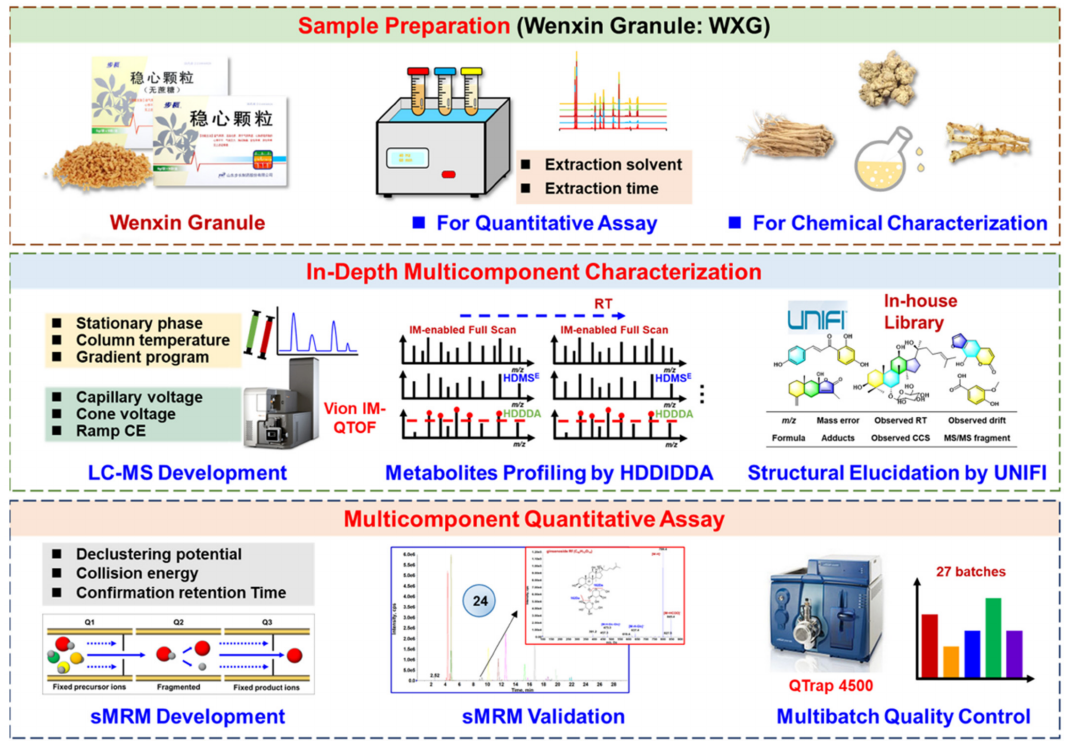
Figure 1. Quality evaluation of Wenxin granule (WXG) via UHPLC/IM-QTOF-MS-based multicompo- nent characterization and quantitative assay using scheduled MRM facilitated by